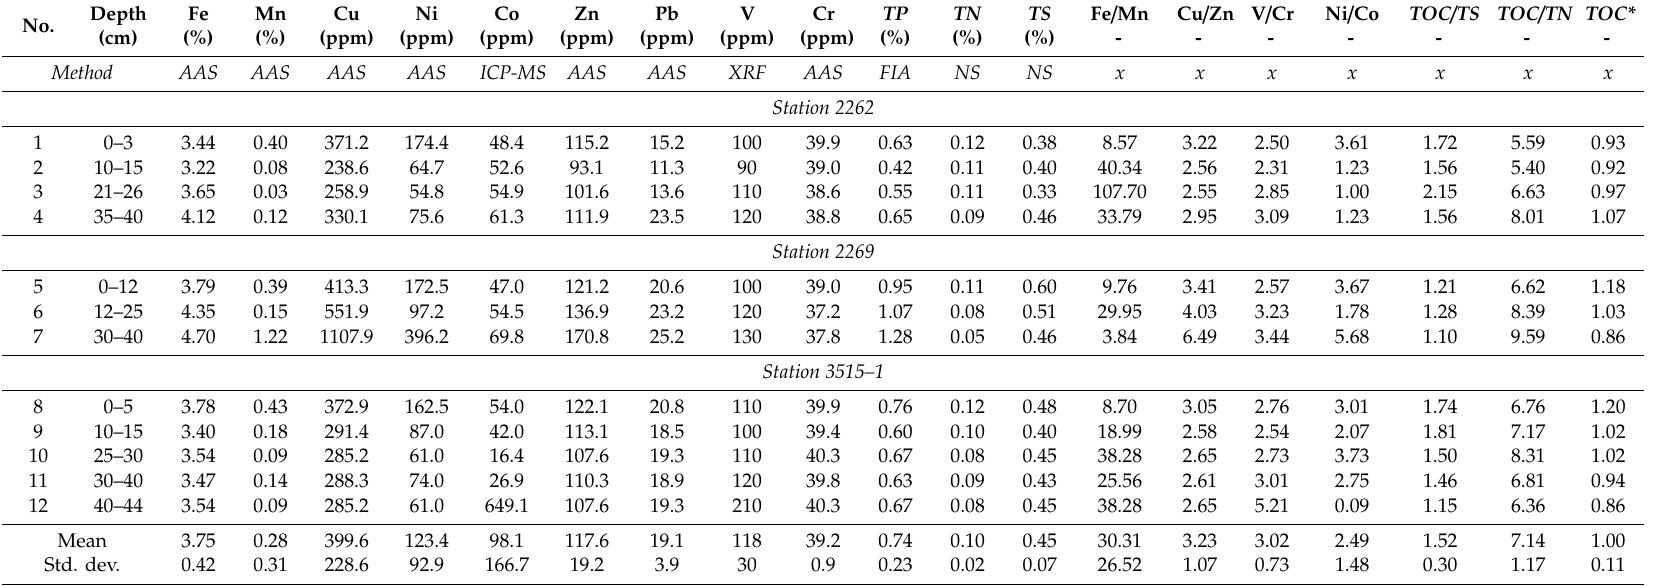
Table 6. Geochemistry of pelagic sediments from the CCFZ, IOM claim area ( n =